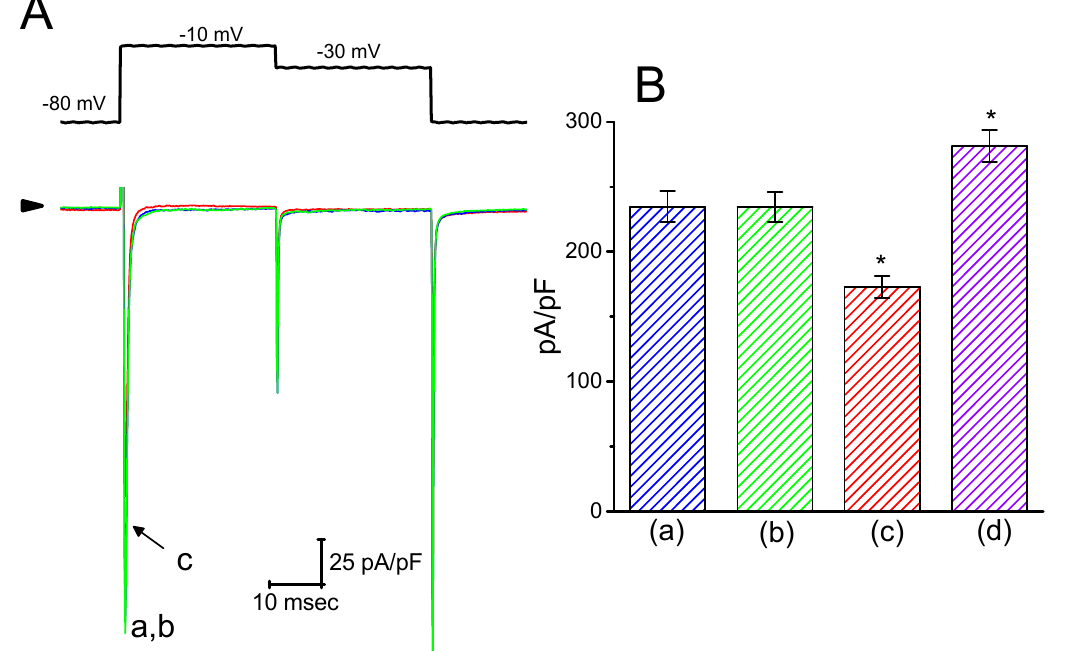
Figure 8. E ff ect of HBA on I Na density recorded in GH 3 cells. Cells were bathed in Ca 2 + -free Tyrode’s solution that contained 10 mM tetraethylammonium chloride and 0.5 mM CdCl 2 . For the recordings, the pipette was filled with Cs + -containing solution. ( A ) Superimposed traces of I Na density elicited by brief depolarizing pulses (indicated in the upper part). The arrowhead indicates the zero current level. (a) control; (b) 30 µ M HBA; (c) 30 µ M HBA plus 10 µ M A-887826. ( B ) Summary of the data showing the e ff ects of HBA, HBA plus A-887826, and HBA plus orthovanadate on the peak density of I Na (mean ± SEM; n = 11 for each bar). The peak density of I Na was measured at the beginning of each brief depolarizing pulse from − 80 to − 10 mV. (a) control; (b) 30 µ M HBA; (c) 30 µ M HBA plus 10 µ M A-887826; (d) 30 µ M HBA plus 10 µ M orthovanadate. * p < 0.05 vs. the control.